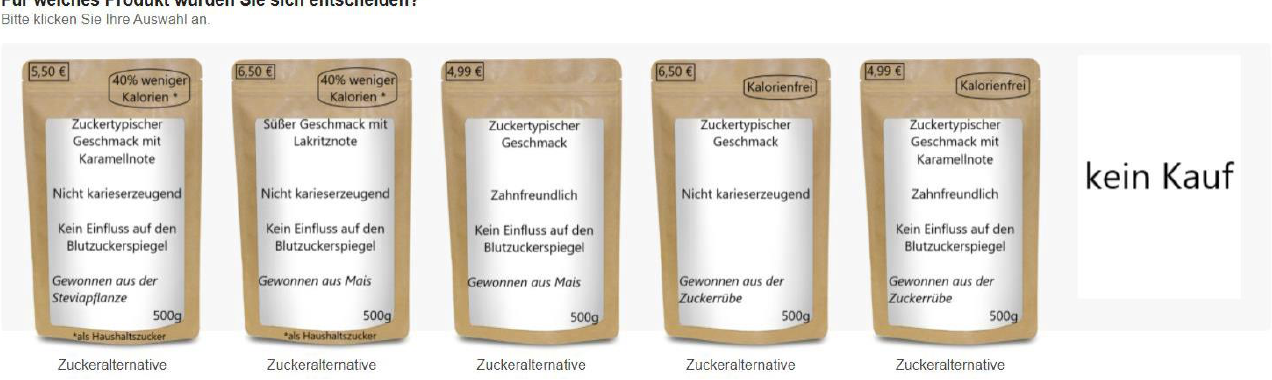
Figure 1. Example of a choice set.